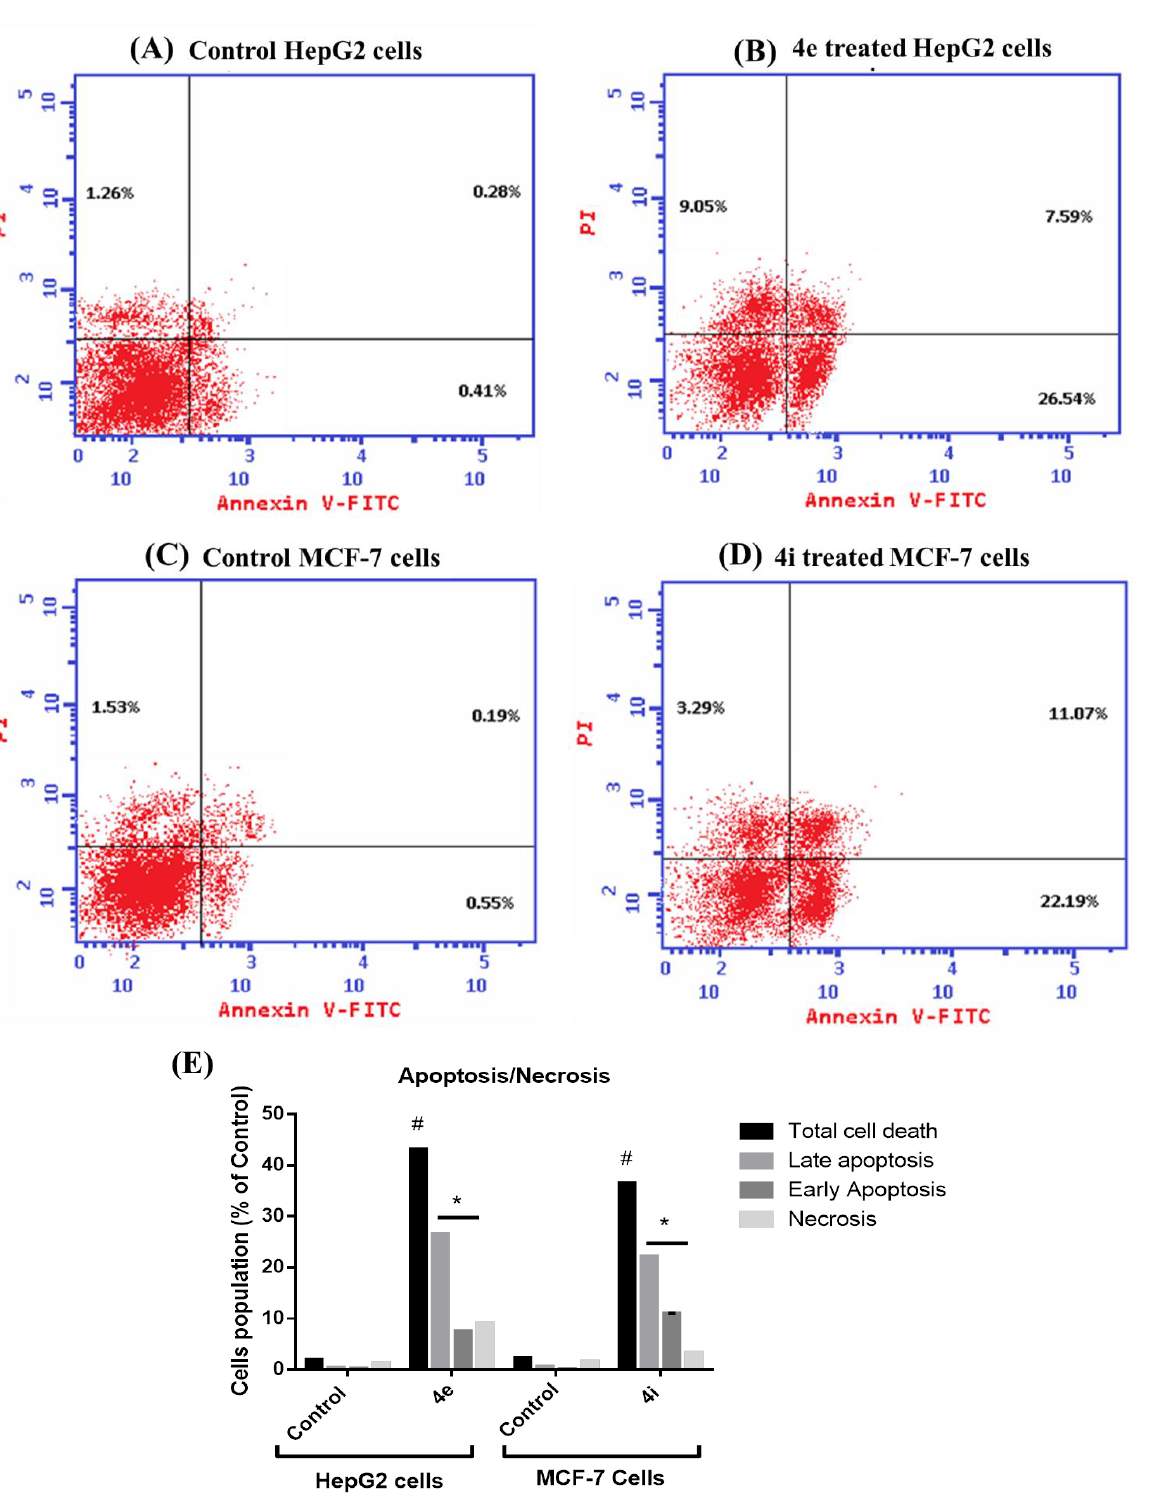
Figure 5. An annexin-V/PI stain for studying apoptosis by flow cytometric analysis. The representative histogram of different cell populations; viable, early apoptotic, late apoptotic, and necrotic cells for ( A ) control HepG2 cells; ( B ) 4e treated HepG2 cells; ( C ) control MCF-7 cells; and ( D ) 4i treated MCF-7 cells. ( E ) A minimum of 10,000 cells per sample were used to calculate the percentage of various cell populations used to determine cell death patterns. Within each experiment, data are presented as the mean standard deviation for triplicates. The one-way ANOVA was used for statistical analysis. * p < 0.05 vs. Necrosis; # p < 0.05 vs. Control.